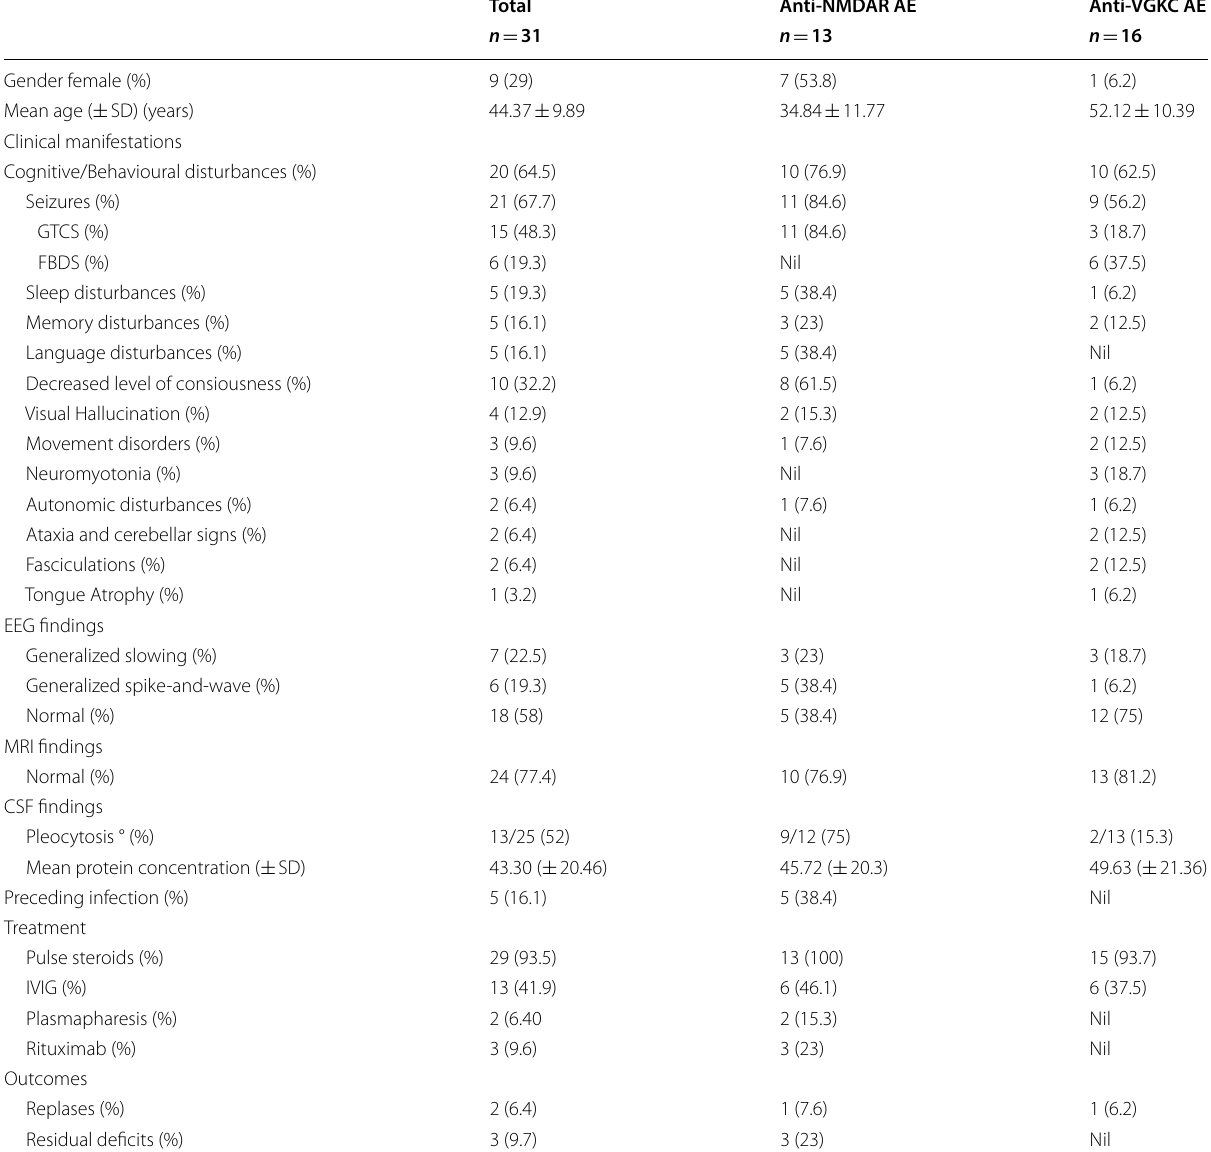
13) and Anti-VGKC =